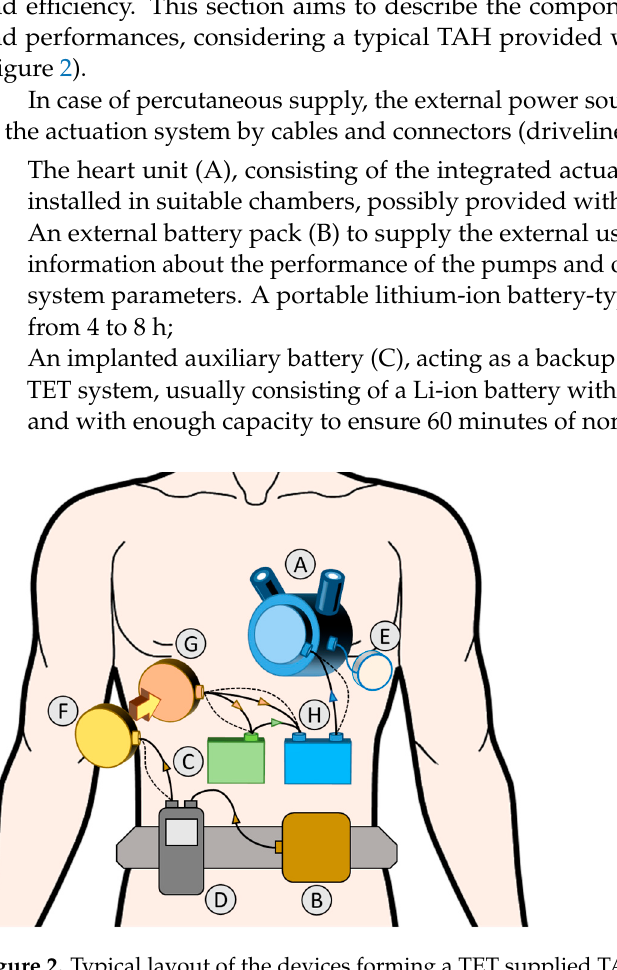
Figure 2. Typical layout of the devices forming a TET supplied TAH; solid lines: power connections; and dotted lines: data transmission cables.